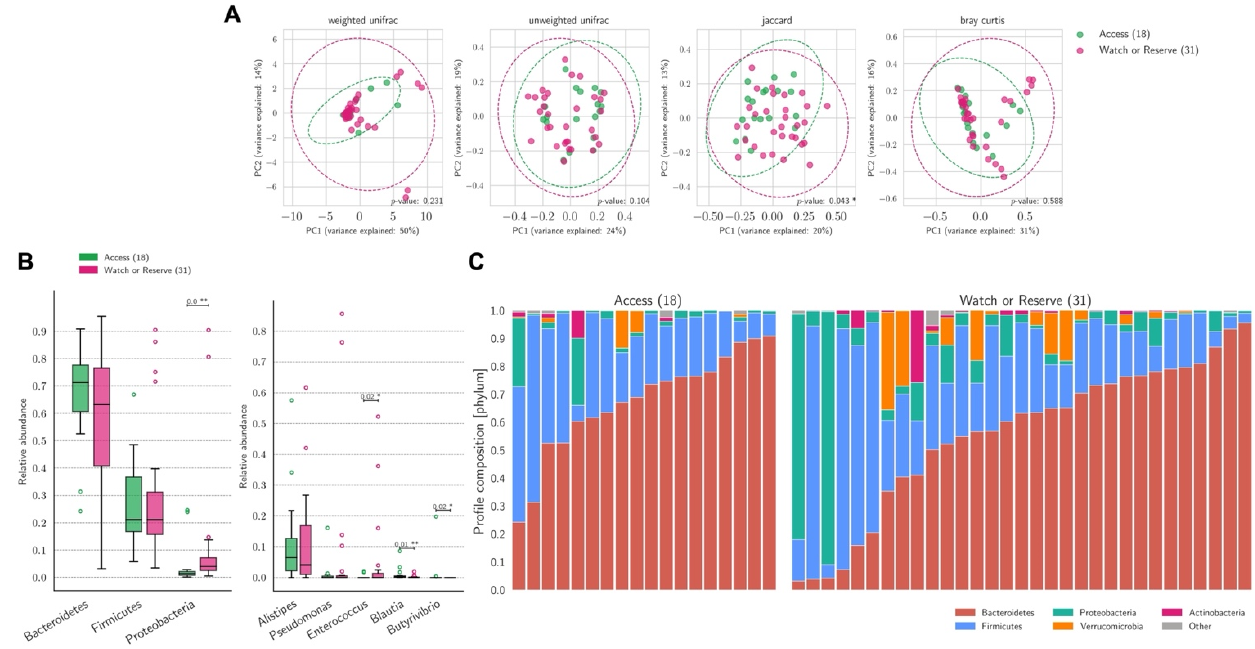
Figure 4. Bacterial beta diversity, relative abundance, and profile composition according to the WHO AWaRe classification for antibiotic use. ( A ) PCoA plots of beta diversity between the three groups showed significant differences in similarity (e.g., Jaccard’s Index) between Access and Watch/Reserve antibiotics. ( B ). Relative abundance analysis showed higher Proteobacteria relative abundance (phylum level) and relative abundance of Enterococcus (genus level) for the Watch/Reserve compared to the access group. ( C ) General profile composition of samples at a phylum level. Access antibiotics were compared to pooled Watch and Reserve antibiotics due to the low ( n = 3) number of treatments using reserve class antibiotics. The 2021 WHO AWaRe classification is available at https://www.who. int/publications/i/item/2021-aware-classification, accessed on 24 September 2022 [15]. Statistical significance reported as * p ≤ 0.05, ** p ≤